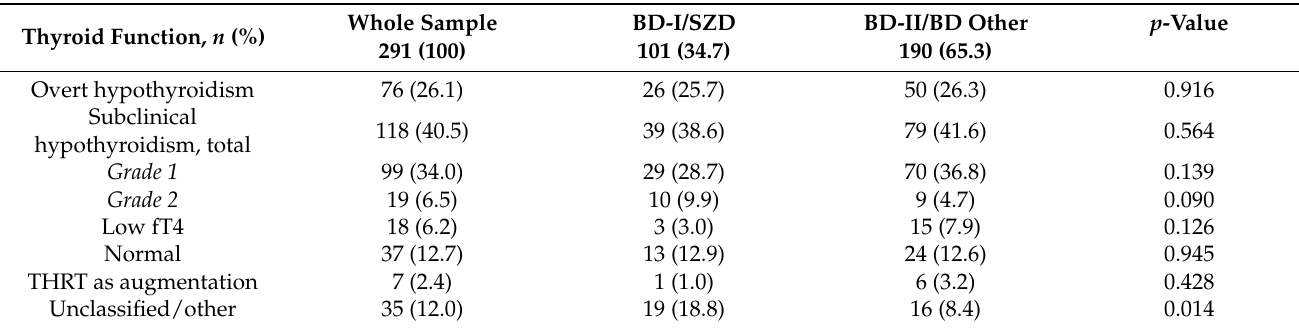
Table 3. Thyroid function at Thyroid Hormone Replacement Therapy initiation, based on thyroid function tests for the whole sample and according to type of bipolar